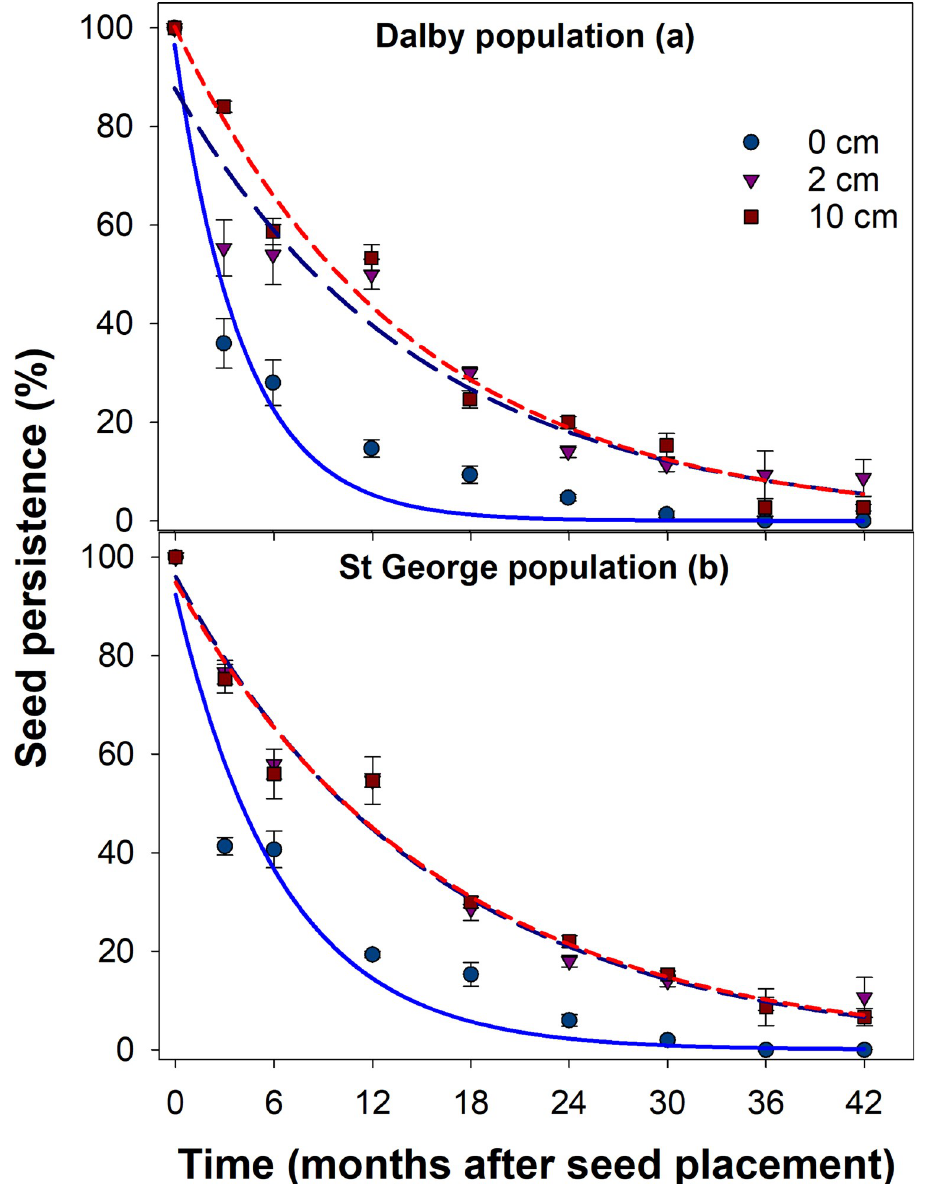
Fig 4. Effect of burial depth and burial duration on seed persistence (%) of two populations [Dalby (a) and St George (b)] of Dactyloctenium radulans . Bars are the standard error of means (n = 3). The curves represent an exponential decay model (red, 0 cm; yellow, 2 cm; and blue, 10 cm) and parameter estimates of the model are shown in Table